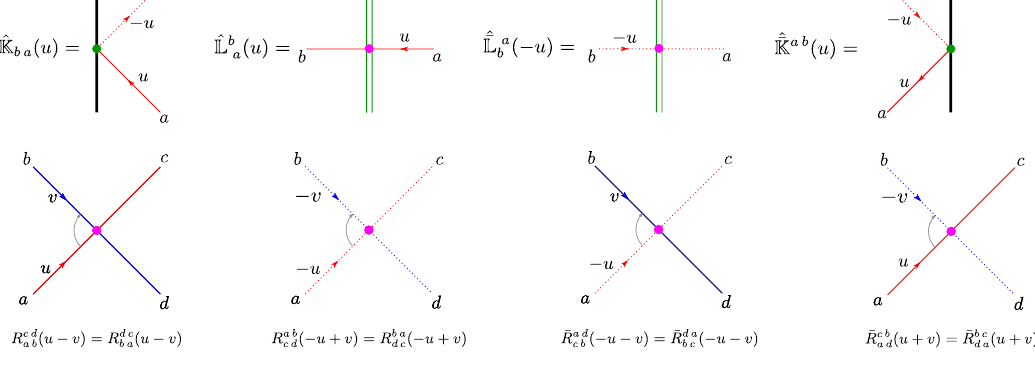
Figure 6. Diagrammatic rules.